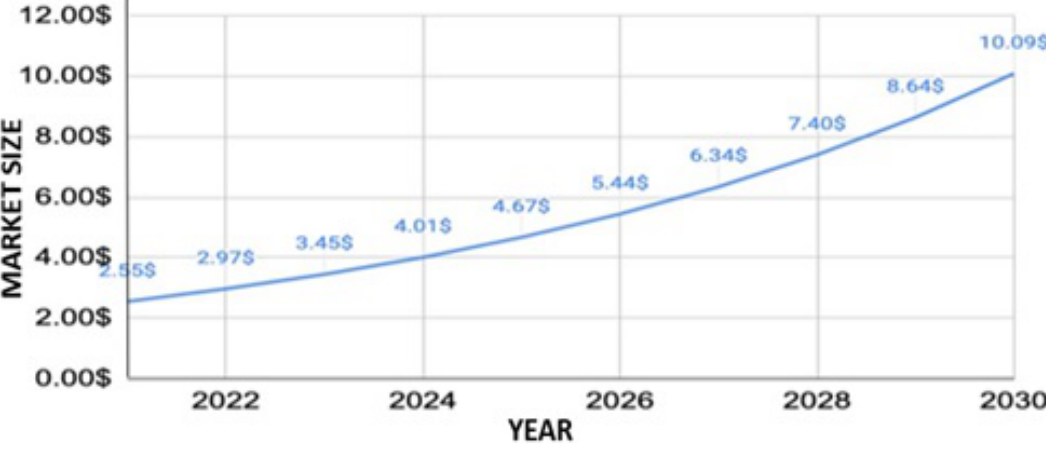
Figure 2. Total projected market size of floating PV [9].